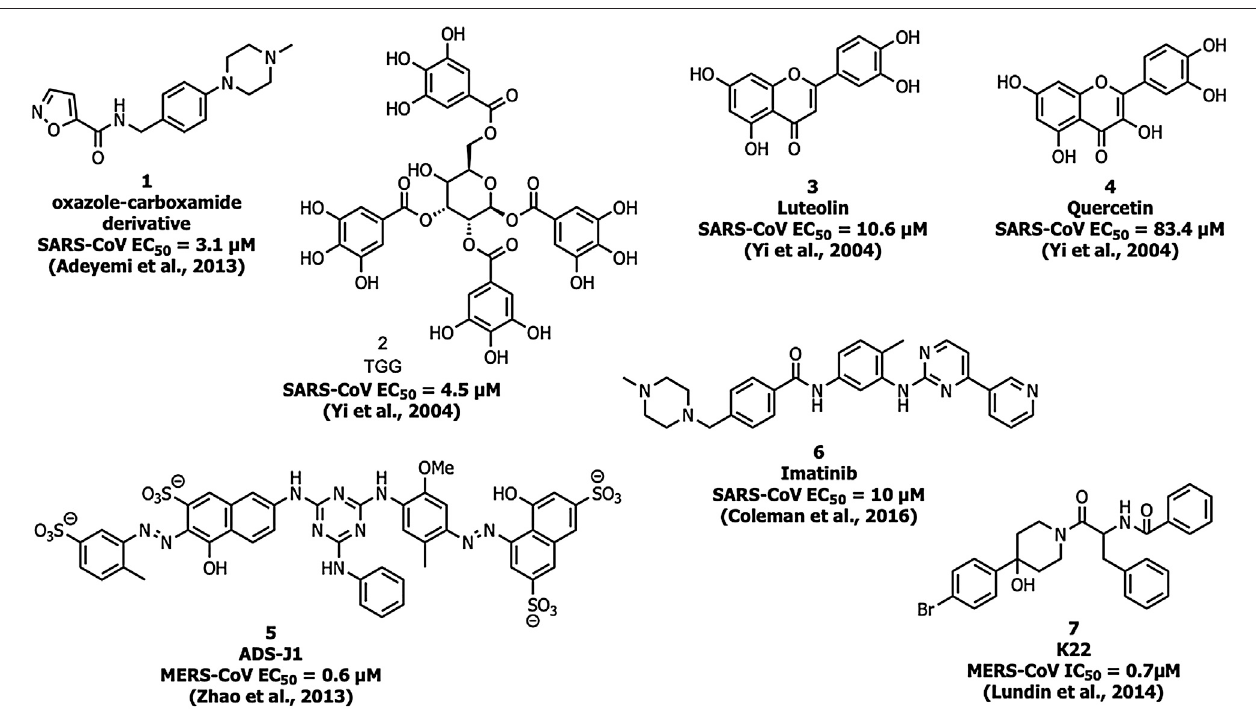
FIGURE 5 | Inhibitors targeting the spike protein S domains S1 and S2.